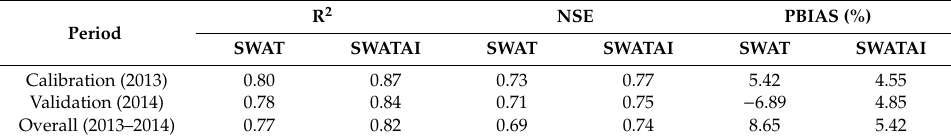
Table 2. Evaluation of simulation results before and after model